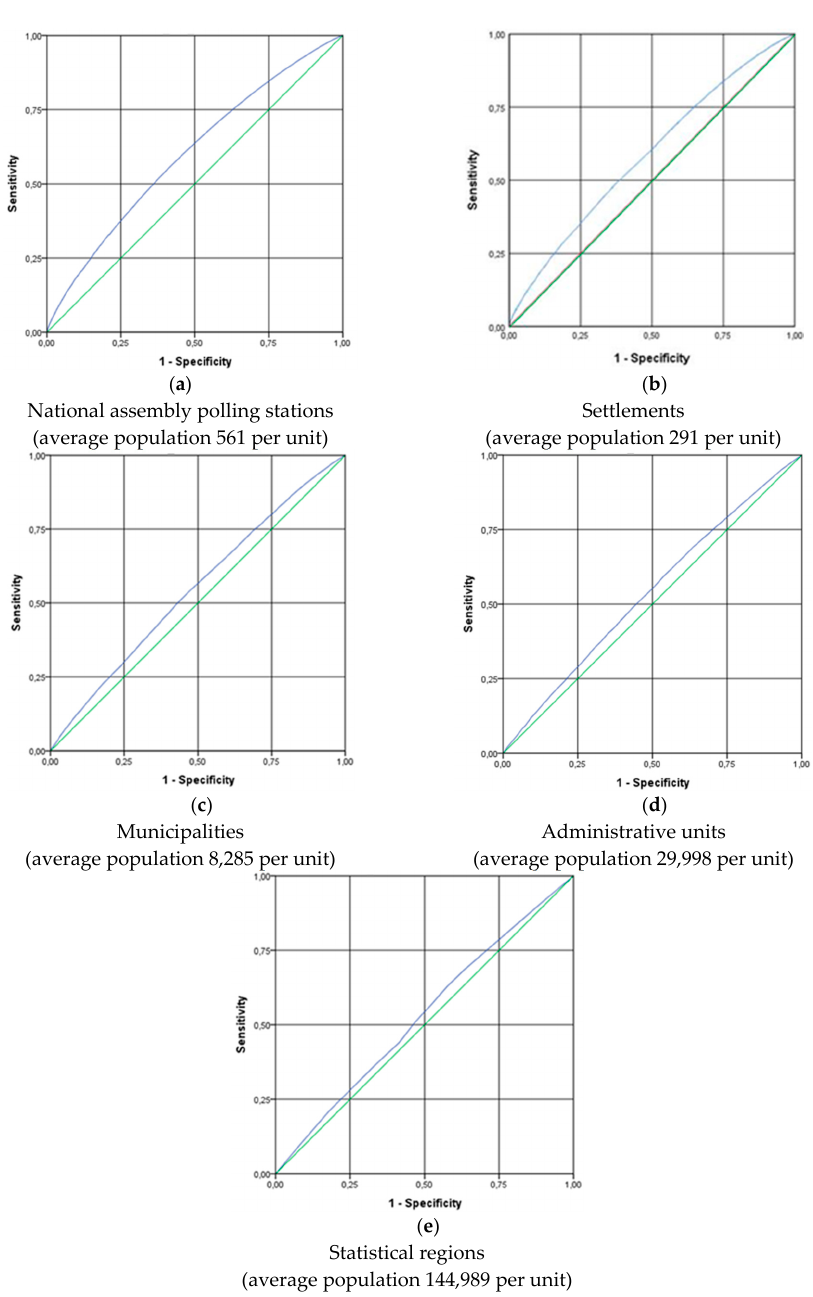
Figure 1. ROC curves of ecological indices at different levels of aggregation according to individual deprivation (aggregated and individual data from population census in 2011): ( a ) SI-EDI-A for national assembly polling stations; ( b ) SI-EDI-A for settlements; ( c ) SI-EDI-A for municipalities; ( d ) SI-EDI-A for administrative units; ( e ) SI-EDI-A for statistical regions. In an ROC curve, the true positive rate (Sensitivity) is plotted in a function of the false positive rate (100-Specificity) for different cut-off points of a deprivation index. Each point on the ROC curve represents a different cut off value. The closer the curve follows the left-hand border and then the top border of the ROC space, the more performant the deprivation index. The closer the curve comes to the 45-degree diagonal of the ROC space, the less performant the deprivation